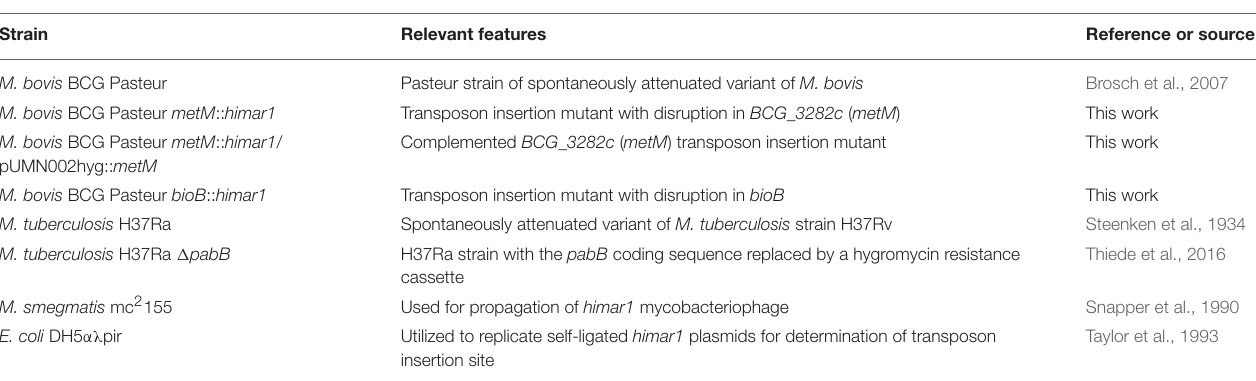
TABLE 1 | List of bacterial strains used in this